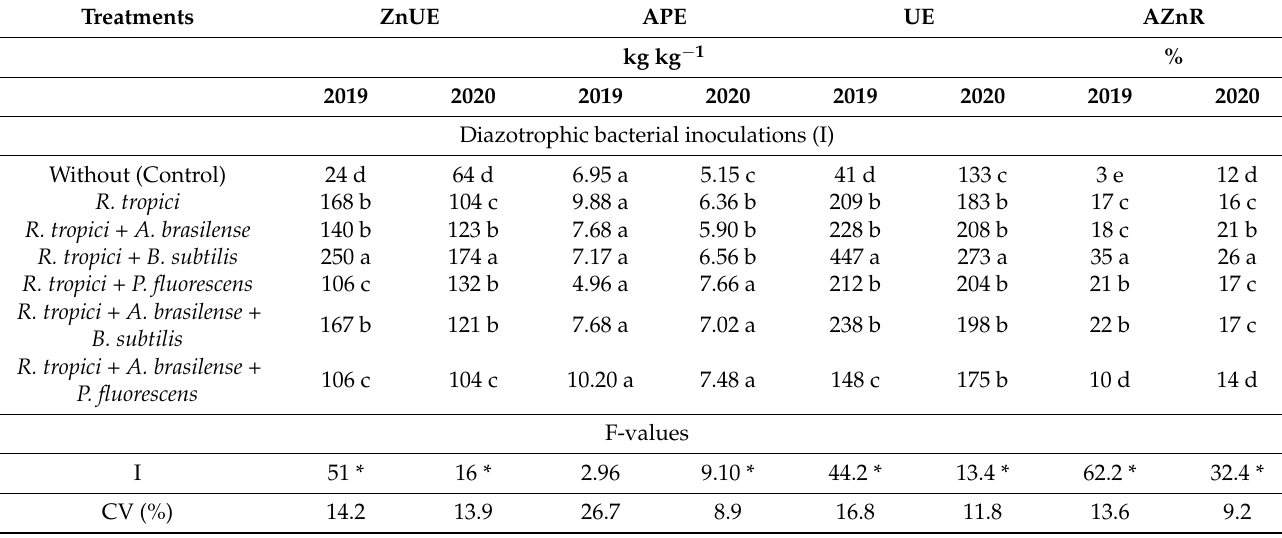
ZnUE = Zinc use efficiency, APE = Agro-physiological efficiency, UE = Utilization efficiency, and AZnR = Applied zinc recovery. Means in the column followed by different letters are significantly different ( p -value ≤ 0.05); * —significant at p < 0.01 and p < 0.05, respectively; and ns—nonsignificant, by